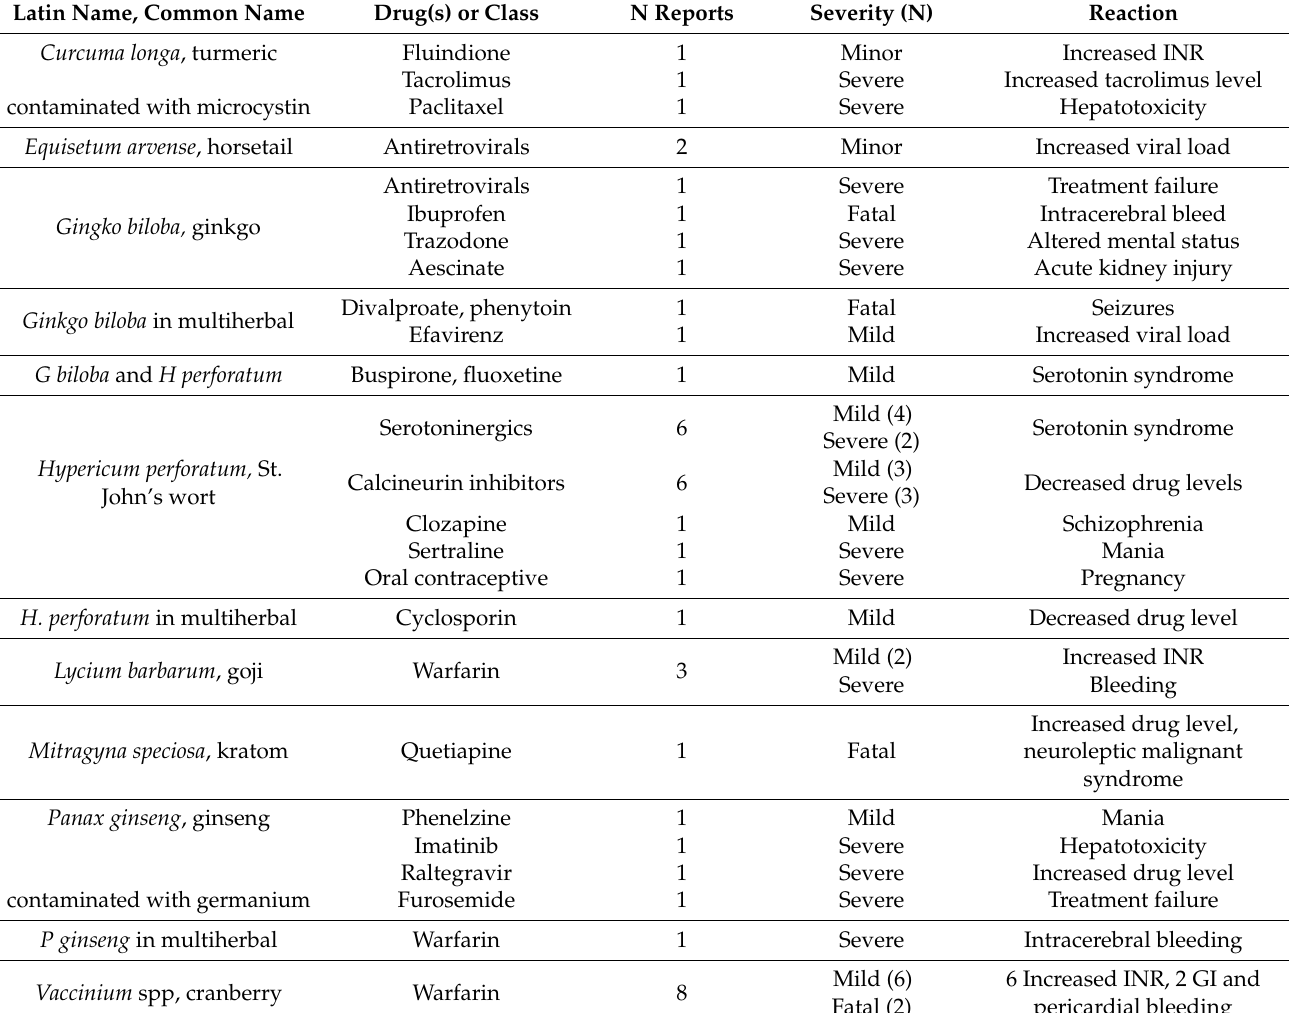
Table 2. Herbs most commonly involved and/or associated with fatal